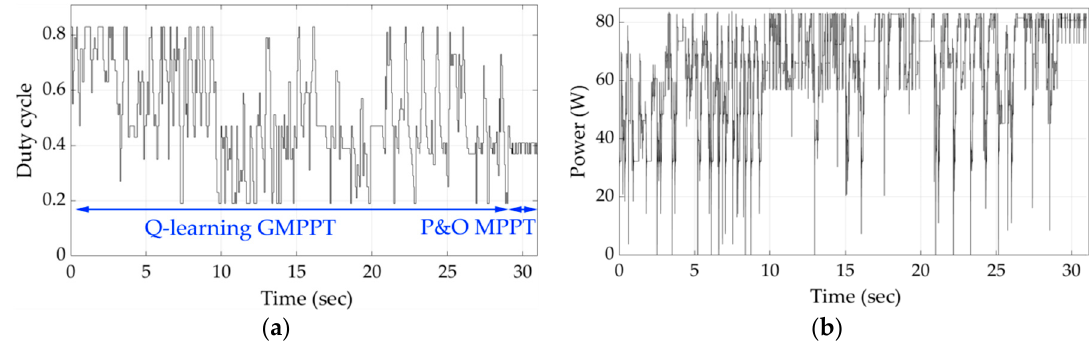
Figure 8. Results during execution of the proposed Q-learning-based GMPPT process for shading pattern 1: ( a ) Duty cycle versus time and ( b ) PV array output power versus time.